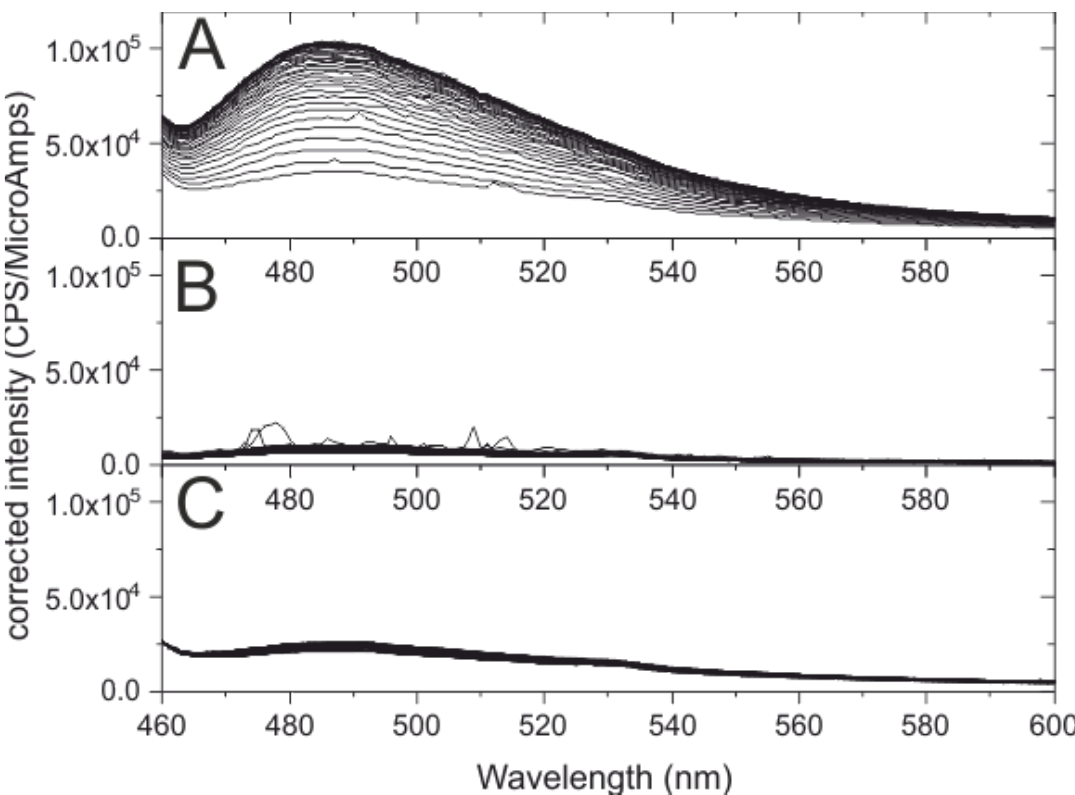
Figure 3. Time-dependent amyloid formation of htt17-Q17: the thioflavin T fluorescence is shown in the presence of 14.5 µM htt17-Q17 and SUVs made of 320 µM POPC/POPS 3/1 mole/mole in 10 mM Tris-HCl buffer, pH 7 ( A ). The peptide-to-lipid molar ratio was 1/22 and a spectrum was recorded every 2 min. The control experiments show almost no changes in thioflavin T fluorescence when exposed to the same amount of htt17-Q17 only ( B ) or SUVs only ( C ). The thioflavin T concentration was 5 µM in all recordings.